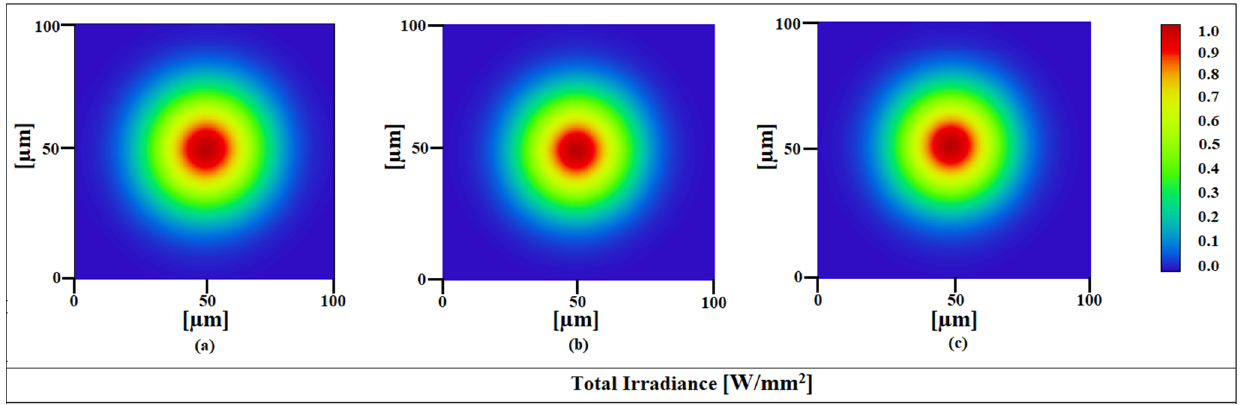
Figure 2. Images of the spectral irradiance on the detector at ( a ) 𝜆 = 0.5 μm ( b ) 𝜆 = 0.6 μm ( c ) 𝜆 = 0.7 μm .